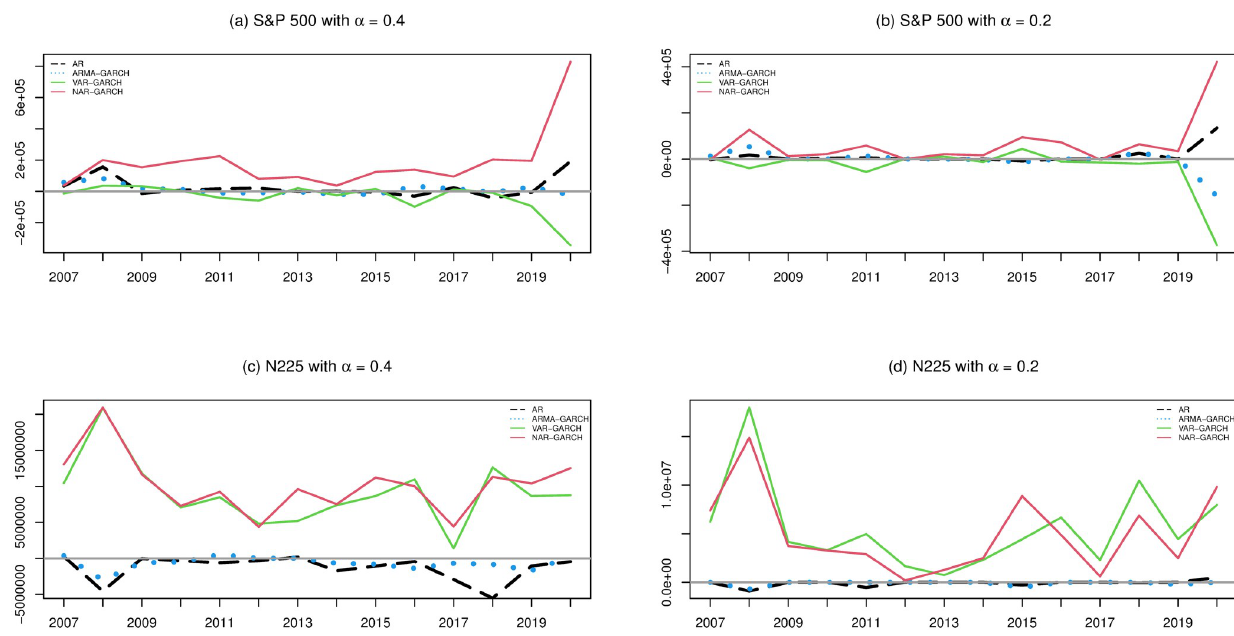
Fig 8. The investment performances of the 4 models for the S&P 500 and N225 indices from 2007 to 2020 with α = 0.2 and 0.4.